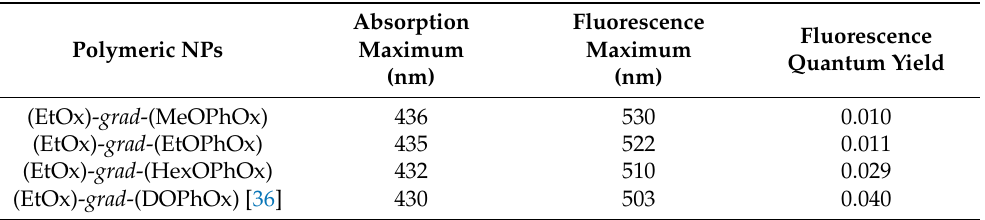
Table 3. Absorption and fluorescence emission maximum and fluorescence quantum yield of cur- cumin encapsulated in polymeric